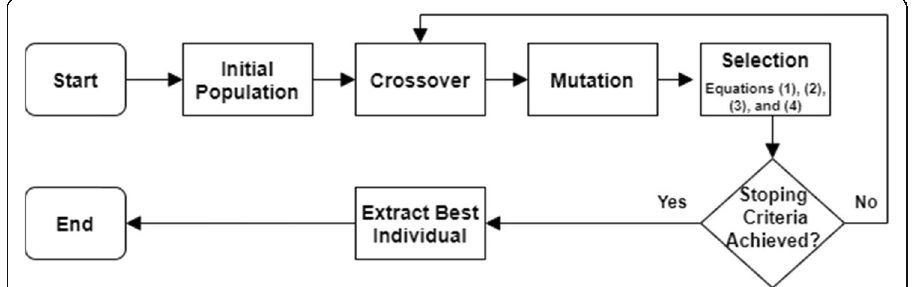
Fig. 2 Flowchart of the proposed complex resource